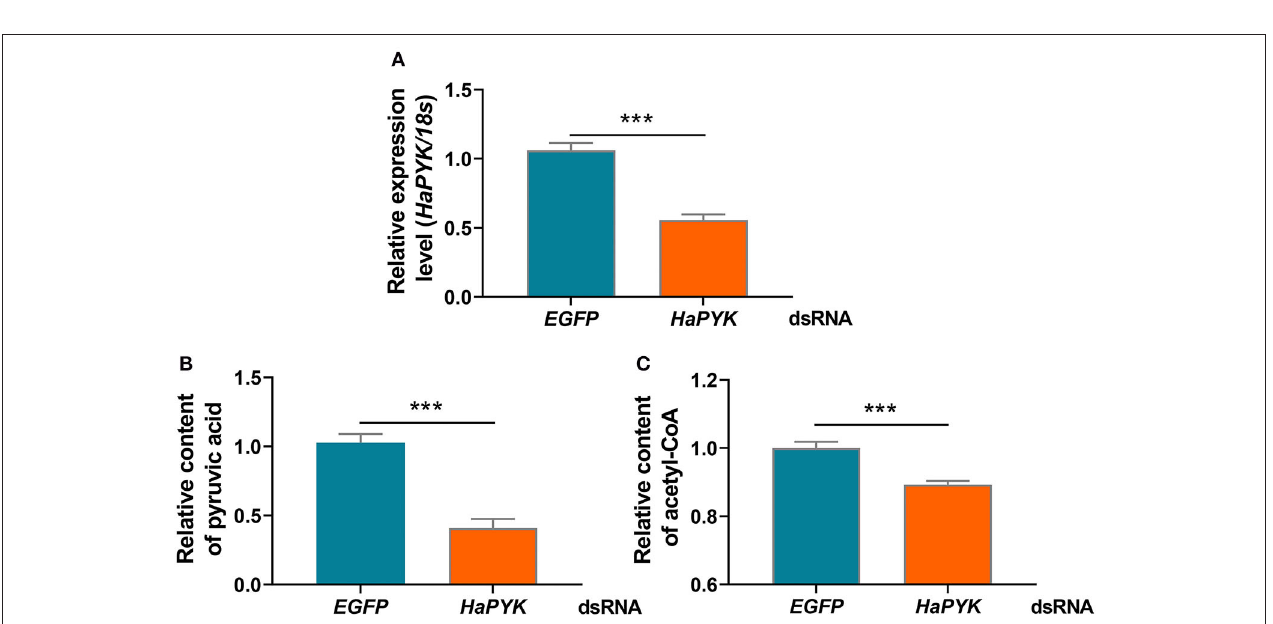
FIGURE 2 | Knockdown of HaPYK decreased the contents of pyruvic acid and acetyl-coA. (A) Inference efficacy of HaPYK in PGs. (B,C) The effect of HaPYK knockdown on the contents of pyruvic acid and acetyl-coA. Error bars indicated the mean ± s.d. of three independent biological experiments, *** P < 0.001 (Student’s t